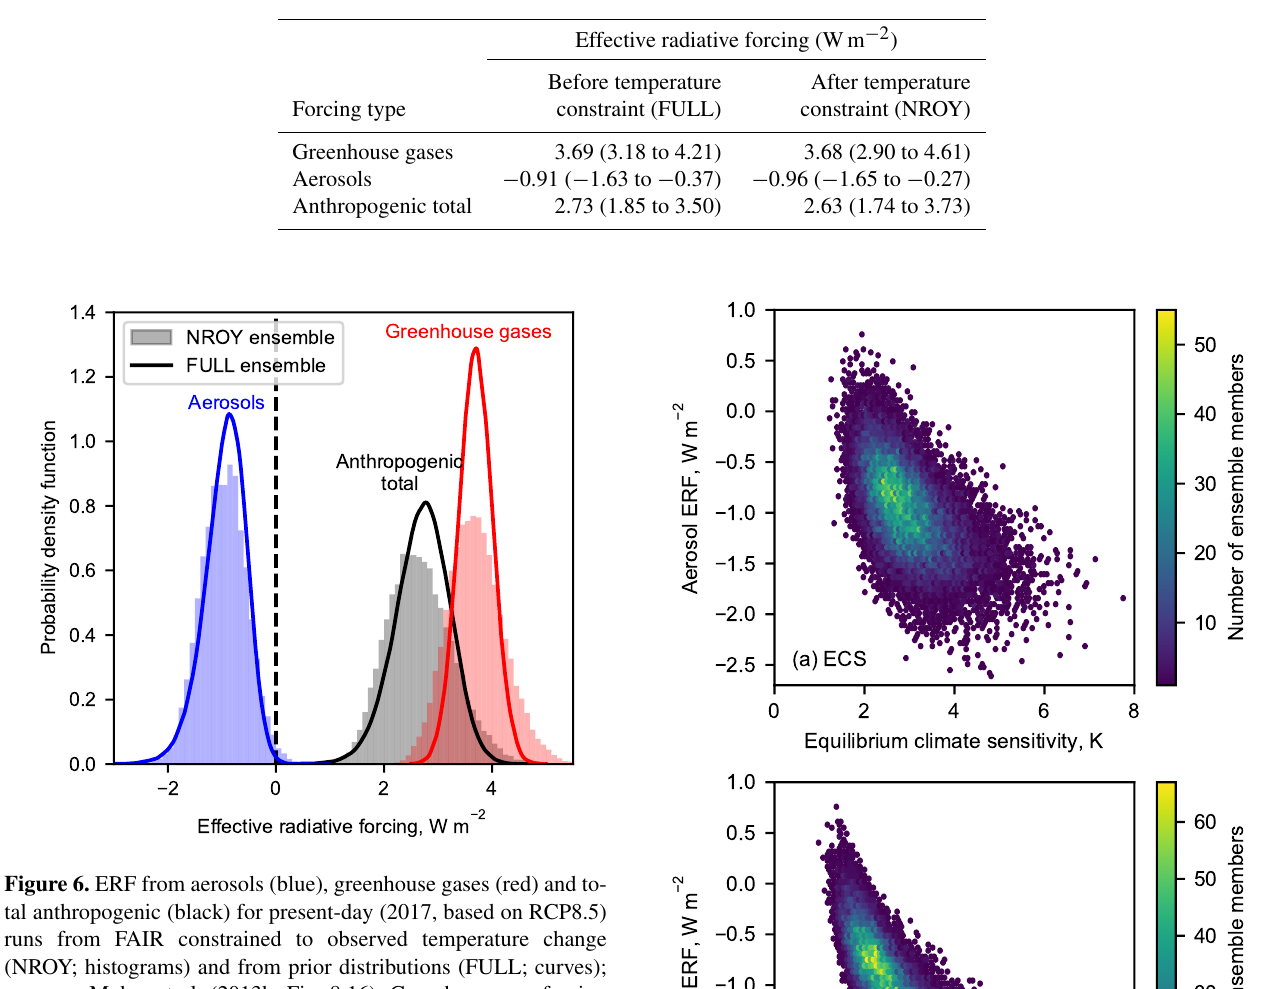
Table 6. Median and 5–95% credible intervals for effective radiative forcing from greenhouse gases, aerosols and anthropogenic total from the FULL and NROY FAIR ensembles in 2017. Anthropogenic total contains contributions from contrails, BC on snow and land use change and therefore is not equal to the sum of greenhouse gas and aerosol forcing. Compare Fig. 6.